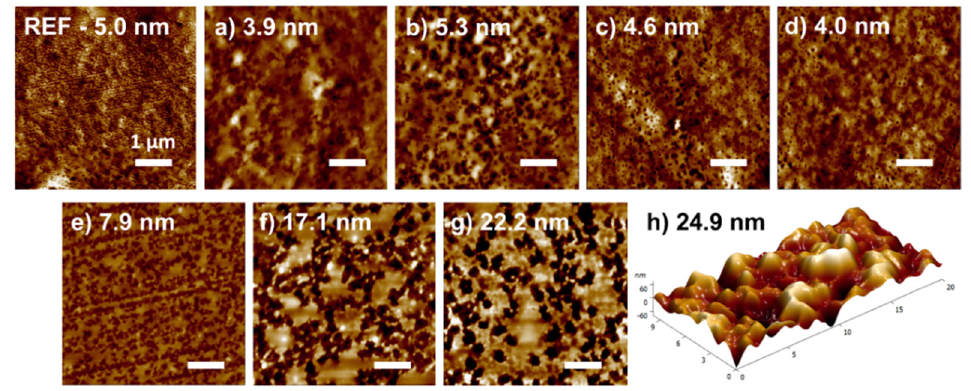
Figure 3. AFM images of BOPP foil treated by plasma at the different experimental conditions: ( a – d ) DCSBD at 1 s, 3 s, 5 s, and 10 s and ( e – h ) VDBD at 1 s, 3 s, 5 s, and 10 s. Values of roughness